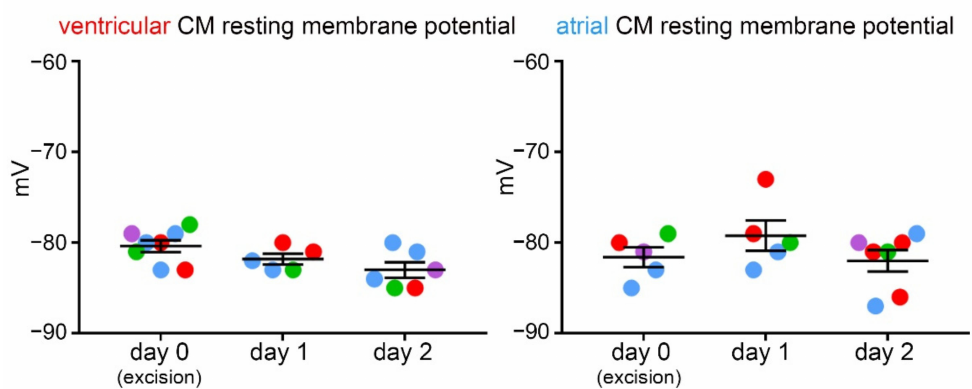
Figure 6. Resting membrane potential in ventricular and atrial CM (free wall and appendage combined) over three consecutive days of cell isolation from live cardiac tissue slices of the same heart; n = 5–8 CM/day of isolation from 3–4 hearts. Each color represents data from one